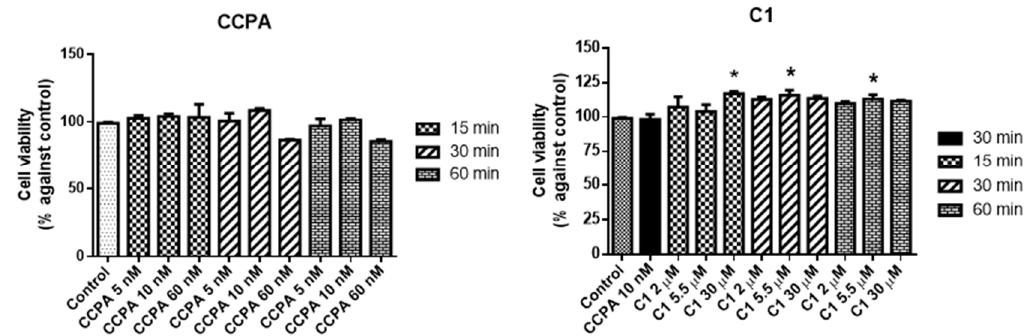
Figure 3. Effects of 2-chloro-N 6 -cyclopentyladenosine (CCPA) and C 1 on mixed glial cell culture viability. Percentage of cell viability after treatment with different ligand concentrations (2 - 30 µM) for 15, 30, or 60 min of incubation. Results represent the average of 3–5 independent experiments. * p < 0.05 of treated cells against control.